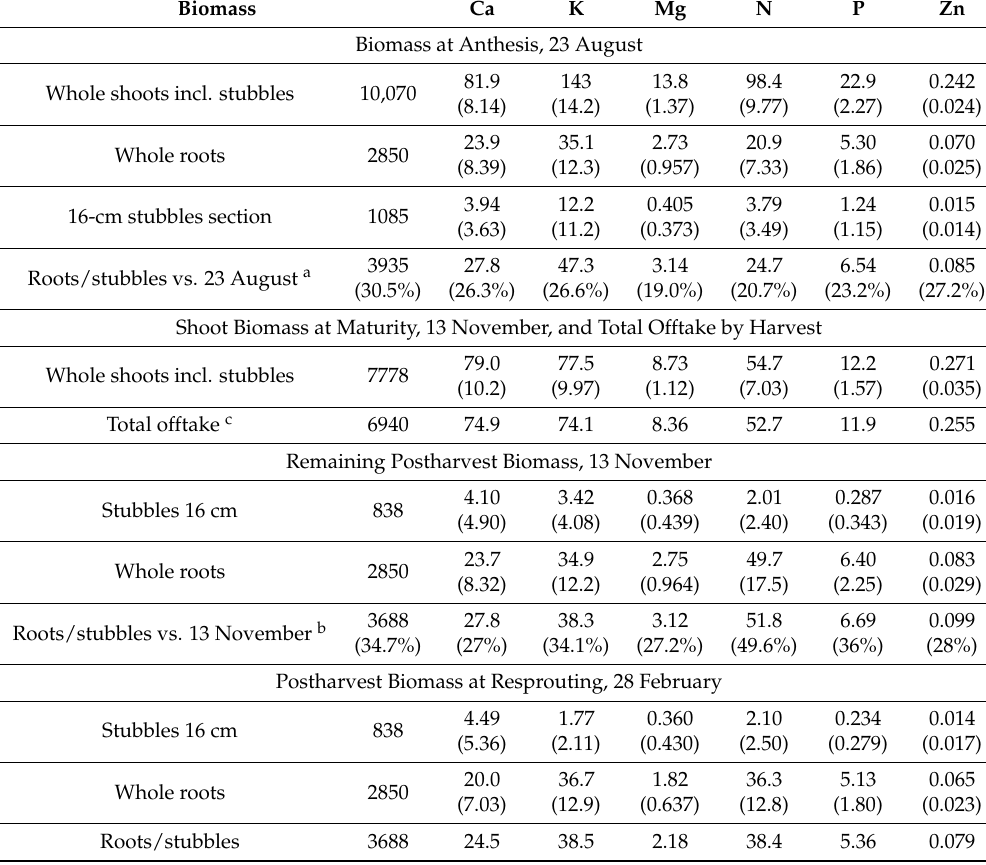
Table 2. Goldenrod: Total biomass and minerals (kg ha − 1 DW) in shoots and roots at blooming (23 August), maturity (13 November), and resprouting (28 February). ( )—concentrations given in kg Mg − 1